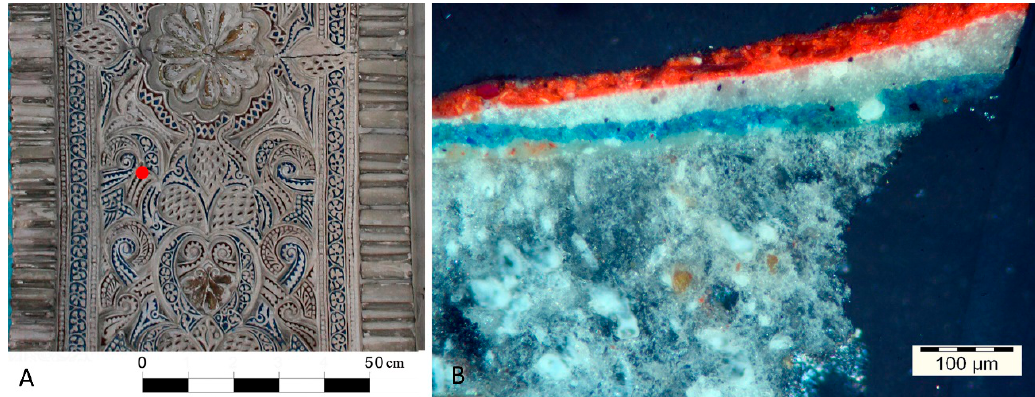
Figure 1. ( A ) Plasterworks in the intrados of the access gate of Carlos V room in Real Alcázar of Sevilla. The red dot highlights the area where the sample was collected. ( B ) Stereo microscope image of a sample taken from the Patio de las Doncellas in the Real Alcázar in Sevilla where there is presence of whitewash and red polychromy hiding its original blue color.